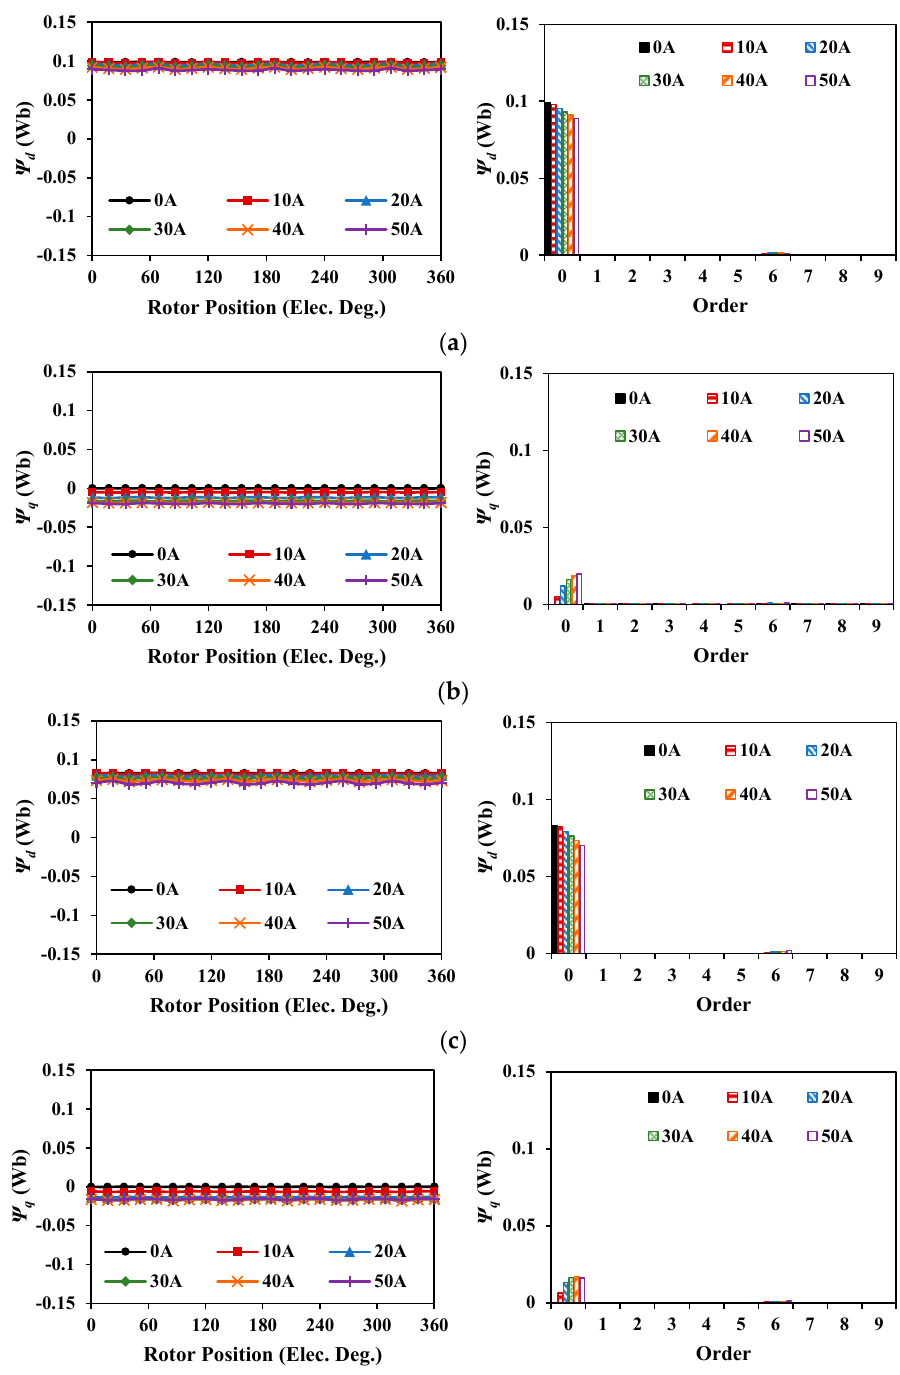
Figure 13. Flux linkages and spectra for 12s10p machines. ( a ) D-axis flux linkage of 12s10p-SPM. ( b ) Q-axis flux linkage of 12s10p-SPM. ( c ) D-axis flux linkage of 12s10p-CCPPM. ( d ) Q-axis flux linkage of 12s10p-CCPPM.